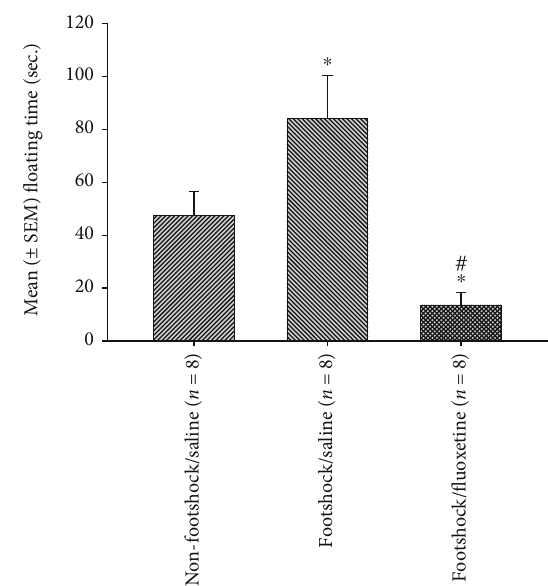
Figure 2: The mean ( ± SEM) freezing time (sec.) over three sessions of the situational reminder phase for the nonfootshock/saline, footshock/saline, and footshock/ fl uoxetine groups ( n = 8 , per group).